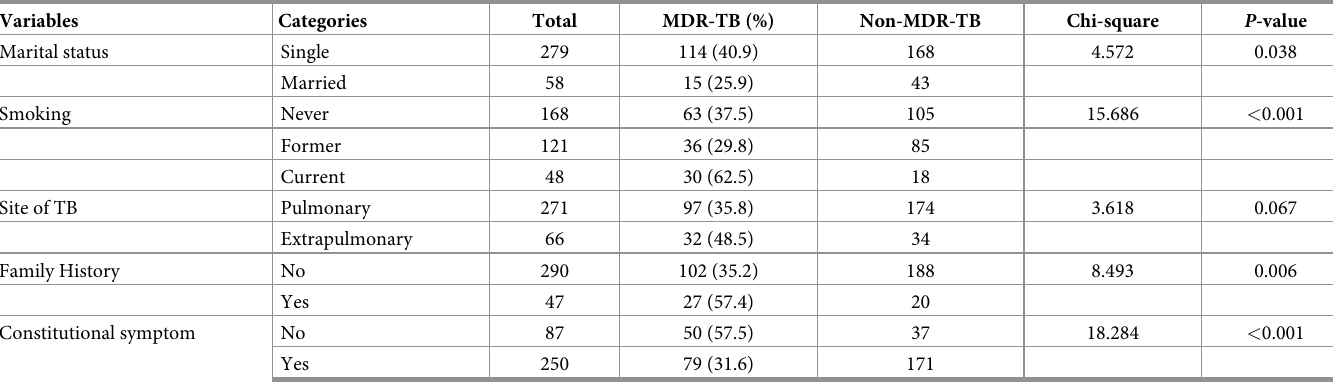
Table 5. Comparison of MDR-TB and Non-MDR-TB patients in Liberia (n = 337). Variables